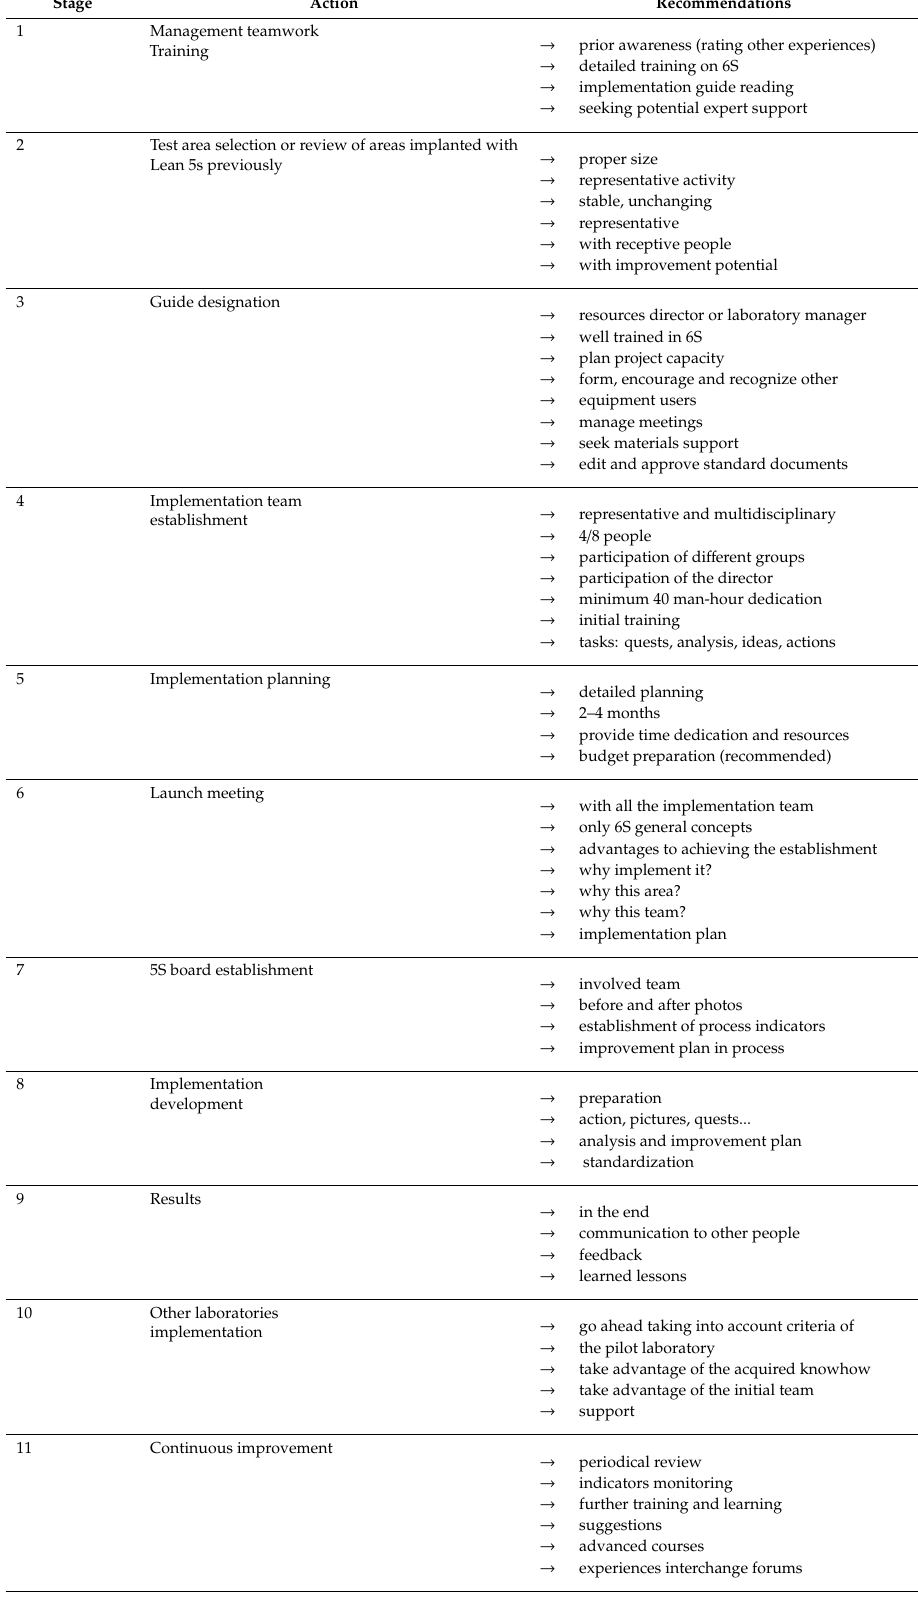
Table 5. 6S process